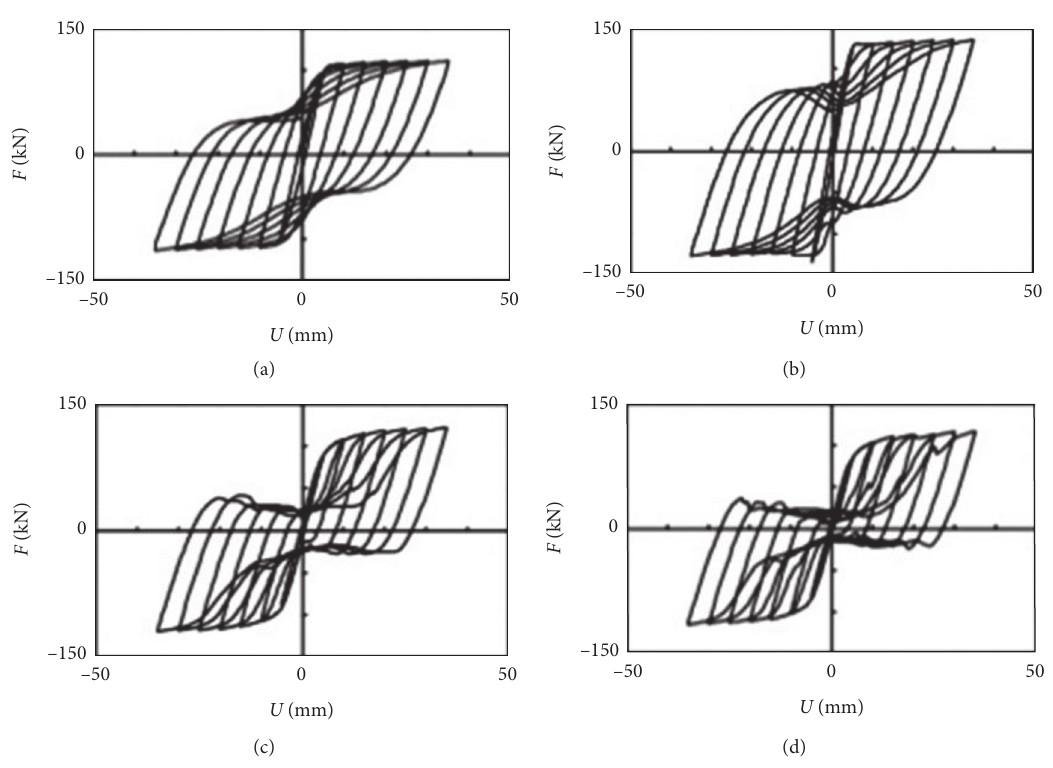
Figure 5: Hysteresis behavior of steel shear panels. results, and data obtained from the tests are available in Figure 10 represents a ring-shaped hysteresis load-dis- Table 3. Results prove preventing from strain in bracing as placement for the given panel. Comparing the panel in the well as the SSW system has a big effect on reinforcement of absence of bracing and stiffener, as well as considering re- panels. Stiffness, resistance, and flexibility of panels after sistance of all panel reinforcements, we achieved good re- reinforcement function as a leading factor concerning sults. Consider Figure 11 which plots axial load against connection between both concrete and steel frames. Bracings transformation in the form of hysteresis rings for the bracing improve resistance and flexibility. However, there is room built with LYP steel. Moreover, Figure 11 represents hys- for study about details when it comes to reinforcement of teresis rings when it comes to shear load versus horizontal panels used in SSWs. displacement. Experiments on SSWs provided asymmetric